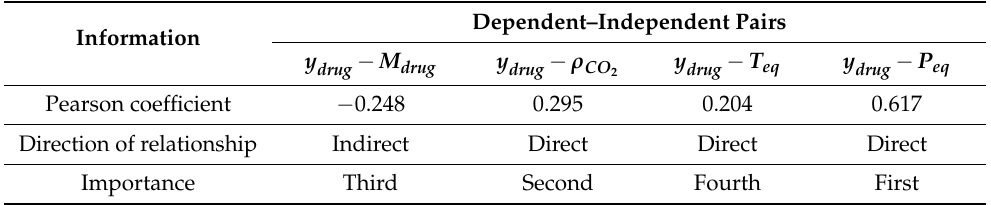
Table 6. Dependency of anticancer drug solubility in supercritical CO 2 on the independent varia- bles.